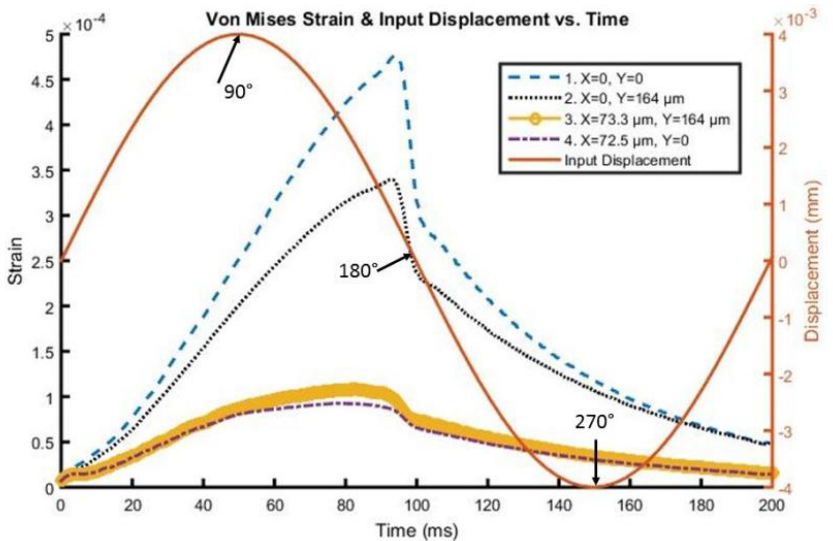
Figure 6. Von Mises Strain versus time along the interface of the 200 kPa stiff probe with the brain.